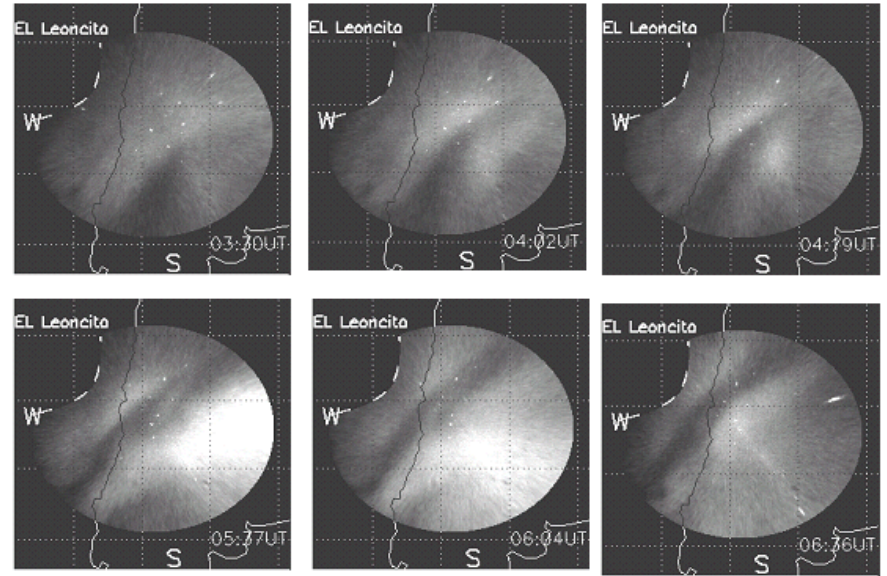
Fig. 10. Airglow depletions associated with mid-latitude instabilities detected by optical images in South America (19 December 2003). The 630.0nm images are mapped to geographical coordinates (“unwarped” with 5 ◦ latitude and longitude lines shown), with north at the top and west to the left. At 03:30 UT a dark band can be seen in the south-east of the FOV that subsequently moves north-westward (the direction predicted for a modified Perkins instability in the Southern